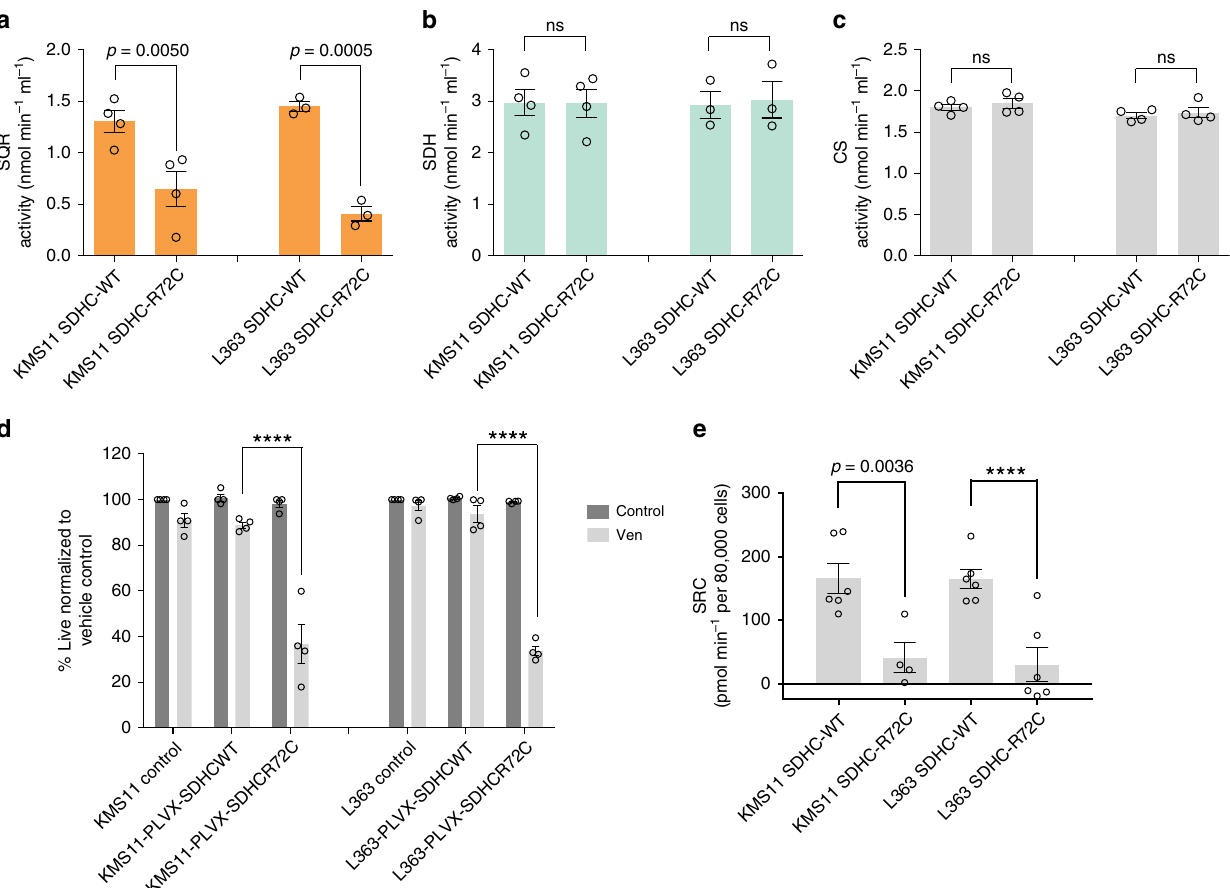
Fig. 4 SQR inhibition via Qp site SDHC-mutant introduction sensitizes MM to venetoclax. a SQR, b SDH and c CS activities were determined in KMS11 and L363, SDHCKO cells expressing SDHC-WT or SDHC-R72C mutant constructs. n = 4 independent experiments except L363 SQR and SDH